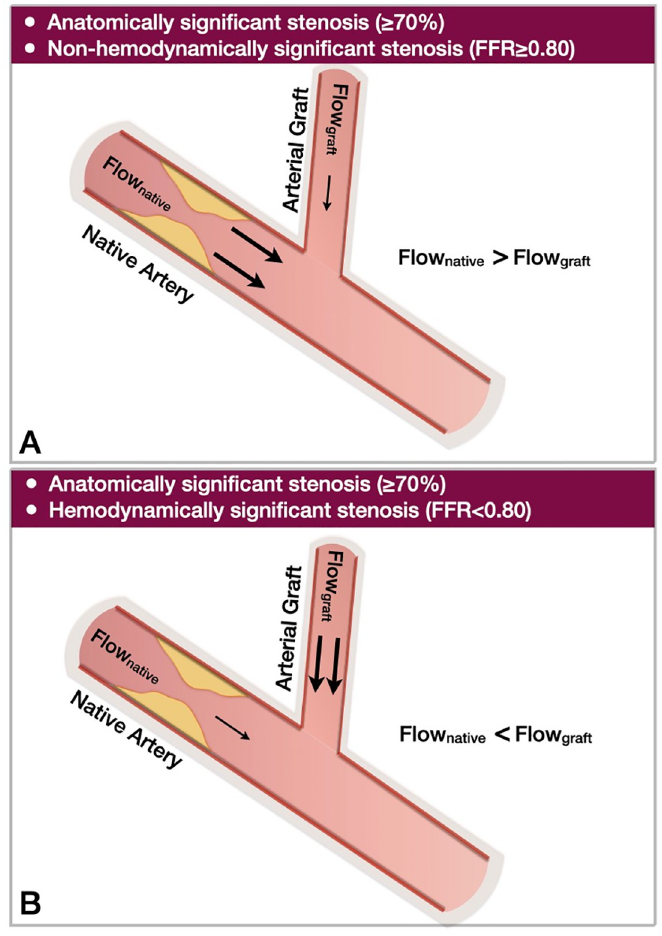
Fig 8. Schematic presentation of the dominant role of the hemodynamic significance over the anatomical significance of a native artery stenosis on the graft flow. A. In anatomically significant but non-hemodynamically significant native artery stenoses, the flow through the native artery exceeds the flow through the graft, B. In anatomically and hemodynamically significant native artery stenoses, the flow through the graft exceeds the flow through the native artery (FFR: fractional flow